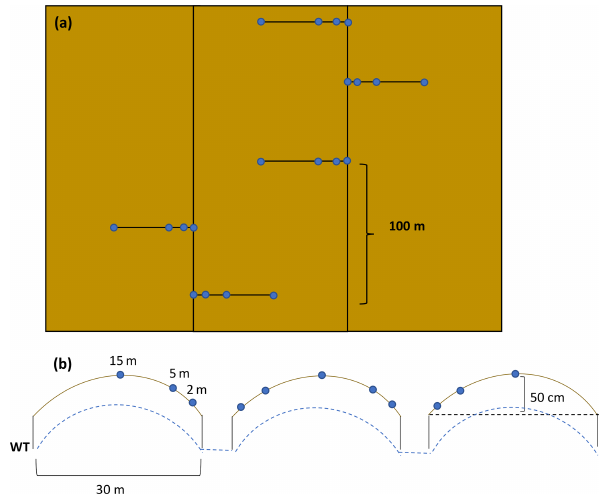
Figure 2. (a) Sampling transects and (b) measurement locations within transects with an estimated elevation increase at the field cen- tre. The field contouring results in about 50cm difference in surface peat elevation between the centre of the field and the edge of the